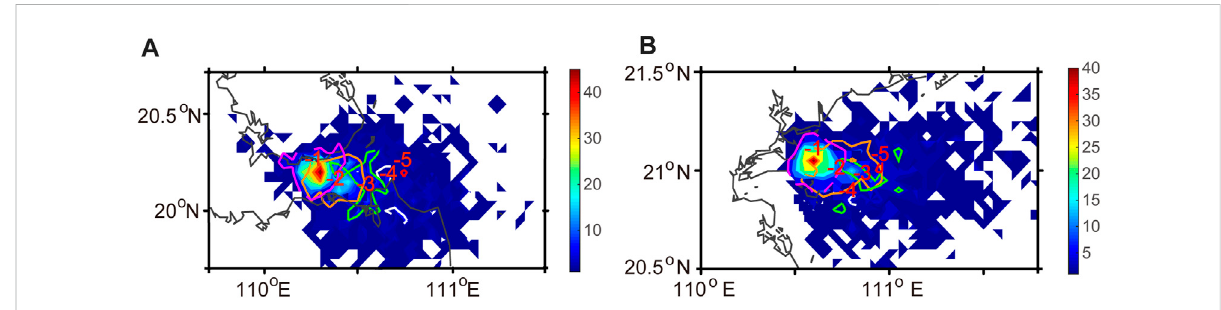
FIGURE 6 Superimposed hourly backward trajectory frequency distribution from 1 h before the onset of sea fog (t = − 1) to 6 h before (t = − 6). (A) Xuwen harbor. (B) Zhanjiang harbor.Shaded partsshow thehourly frequencyoverlaid(butnotaccumulated) ofeachgridfromt= − 1tot= − 6.Contours are theisoline for frequency ofatleast fi veper hour attimes t= − 1 (pink), t= − 2 (yellow), t= − 3(green), t= − 4 (white),and t= − 5 (red).For t= − 6themax frequency is less than 5. Numbers − 1 to − 5 are put at the geometric center of each isoline.